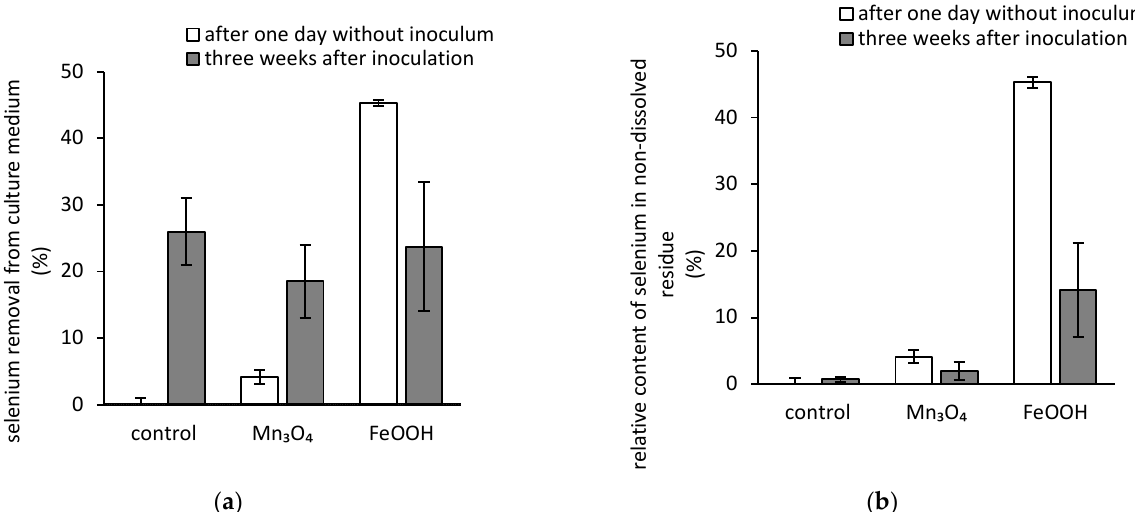
Figure 2. Changes in the concentration of dissolved ( a ) manganese and ( b ) iron in the selenium-free or selenate-treated culture media after the three-week static incubation of hausmannite (Mn 3 O 4 ) or amorphous ferric oxyhydroxides (FeOOH) in the presence of fungus Aspergillus niger (control represents the treatment without any solid inorganic phases).